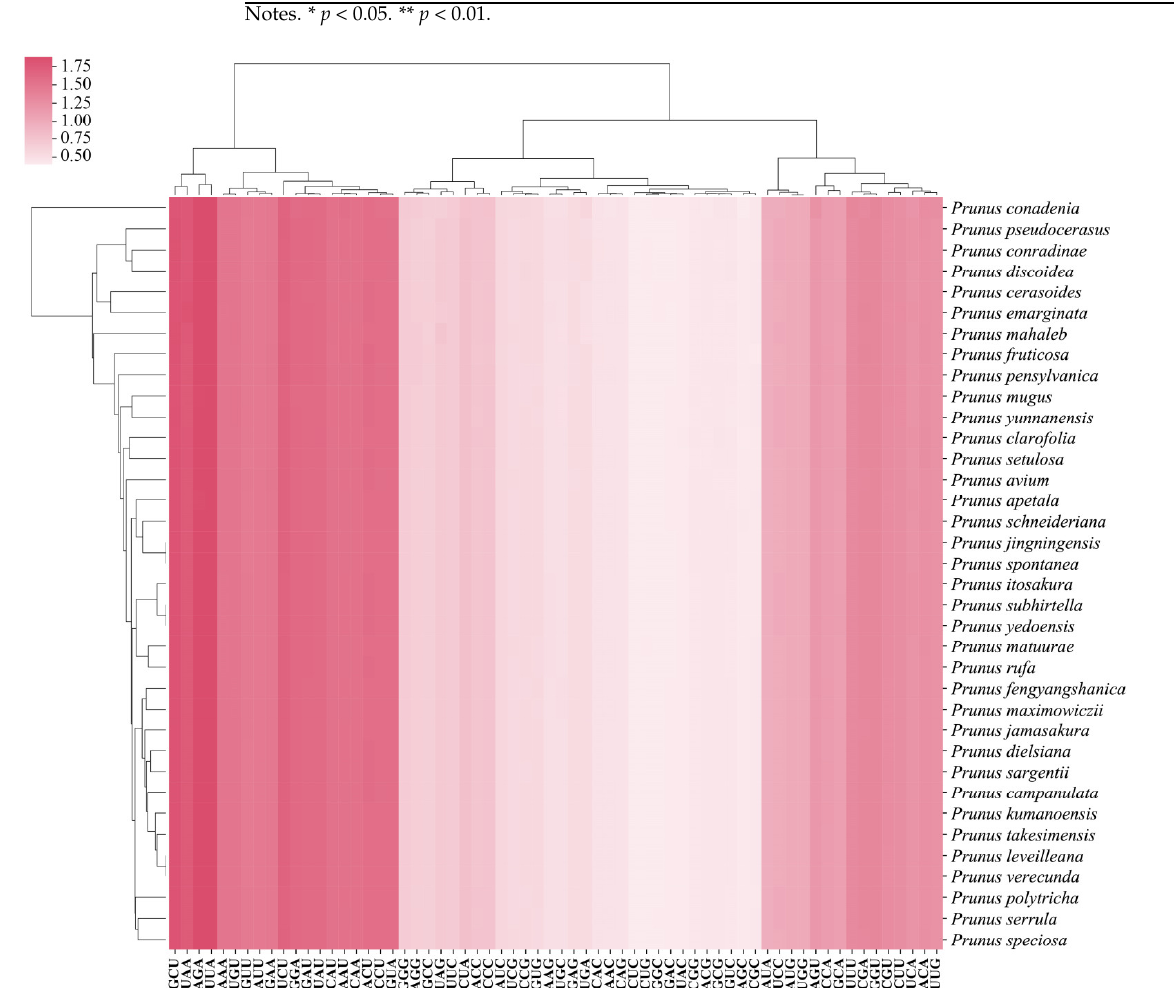
Figure 5. The codon usage of 36 subg. Cerasus based on RSCU values of chloroplast genes. The x-axis indicates the triplet codons, and the y-axis represents the 36 subg. Cerasus accessions.